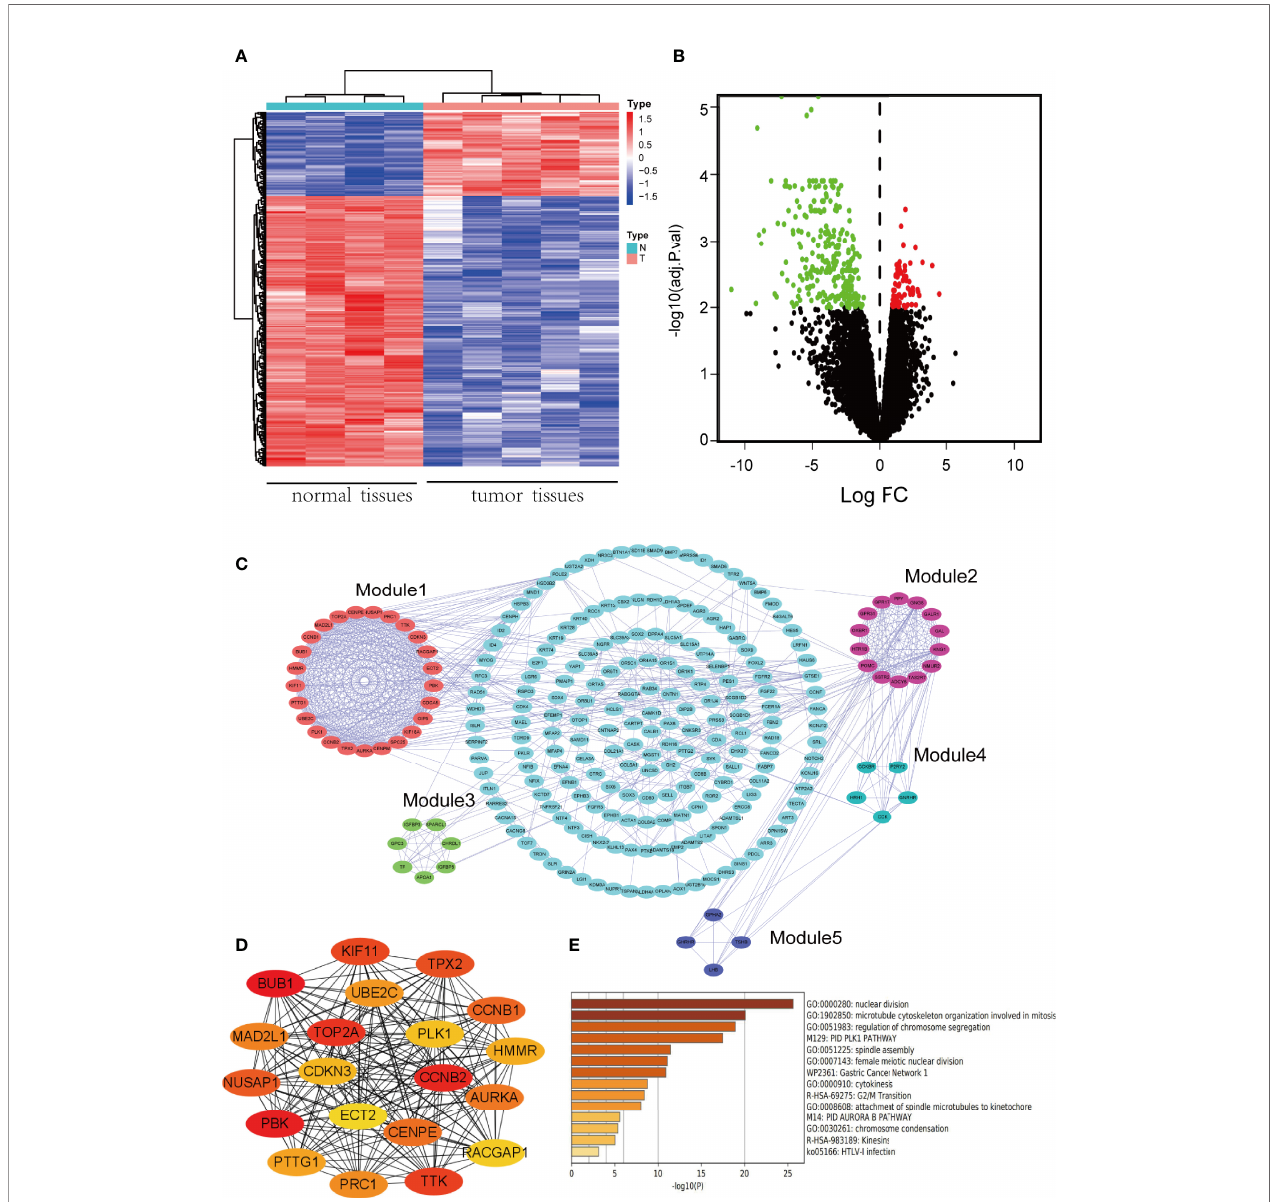
FIGURE 1 | Identi fi cation of DEGs and screening of hub genes. (A) The heatmap of DEGs. Red represents up-regulated genes, and blue represents down- regulated genes. A total of 361 DEGs were identi fi ed. (B) Volcano plot of DEGs. Red denotes up-regulated genes and green denotes down-regulated genes (adj. p - value < 0.01 and |log 2 FC| ≥ 2). (C) PPI network of DEGs. Five modules were identi fi ed by MCODE, which were represented by fi ve different colors. (D) The network of hub genes which was screened by CytoHubba. The higher the ranking, the darker the color. (E) Biofunction and pathway enrichment analysis of hub genes based on Metascape